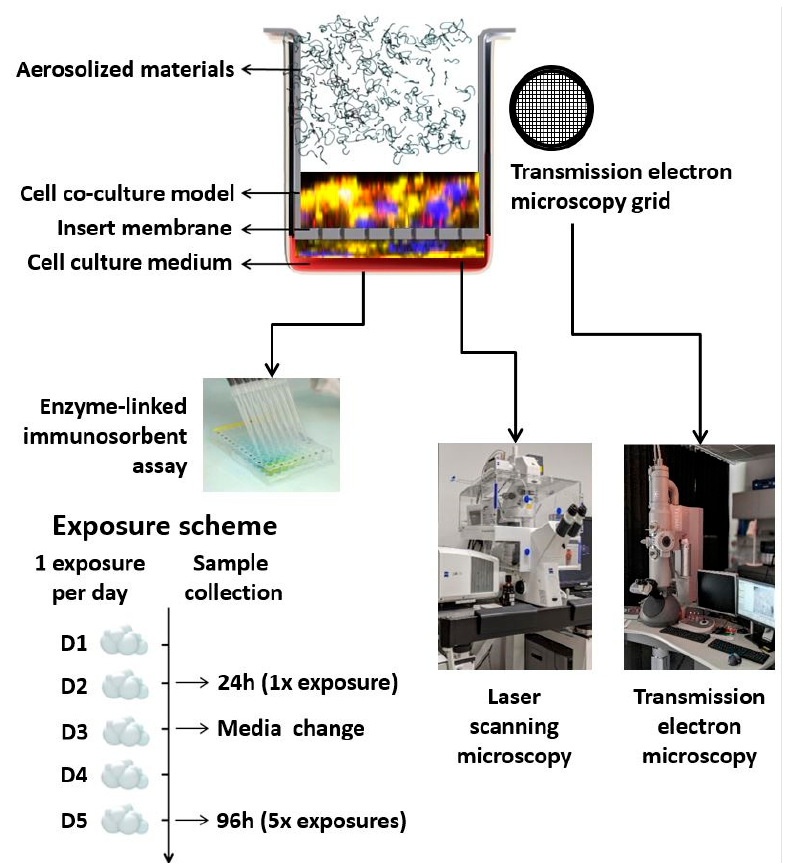
Figure 1. Schematic representation of the experimental setup, exposure scheme, and sample collection.